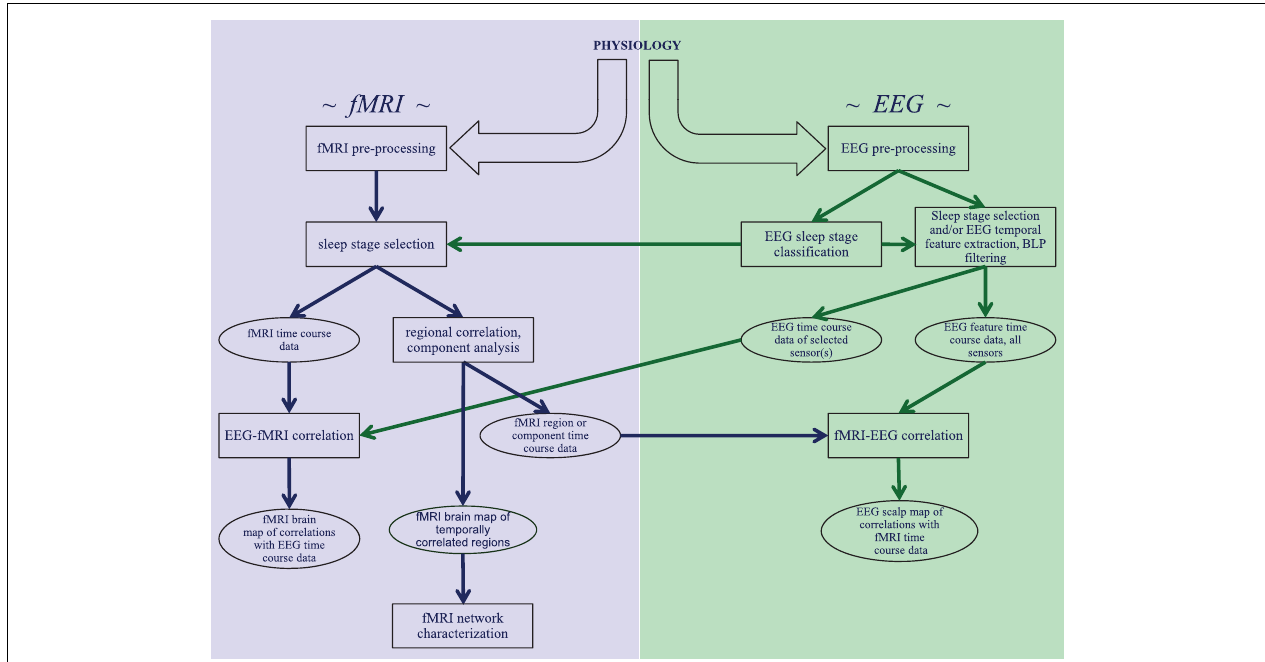
FIGURE 1 | Schematic overview of the analysis strategies and processing steps that are discussed in this review. Three distinct analysis approaches are shown: investigating correlations within fMRI data from sleep stages identified with EEG, correlating EEG features with fMRI data, and correlating fMRI features with EEG